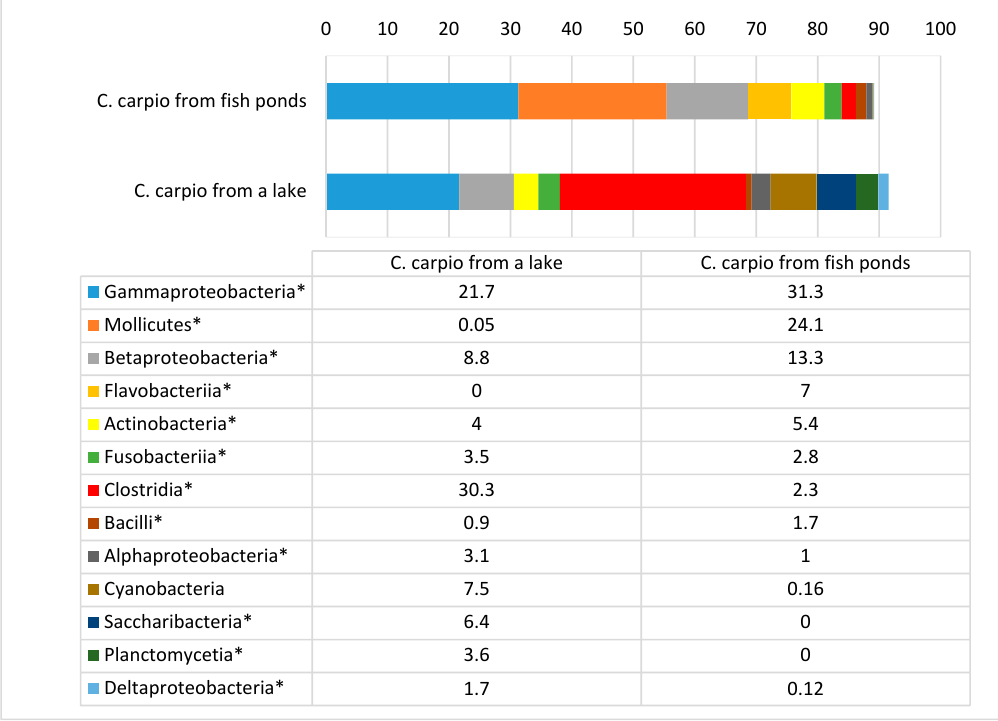
Figure 2. Bacterial class prevalence (%) in C. carpio gut. * statistically significant results ( p ≤ 0.05) between the number of bacteria of separate phyla.